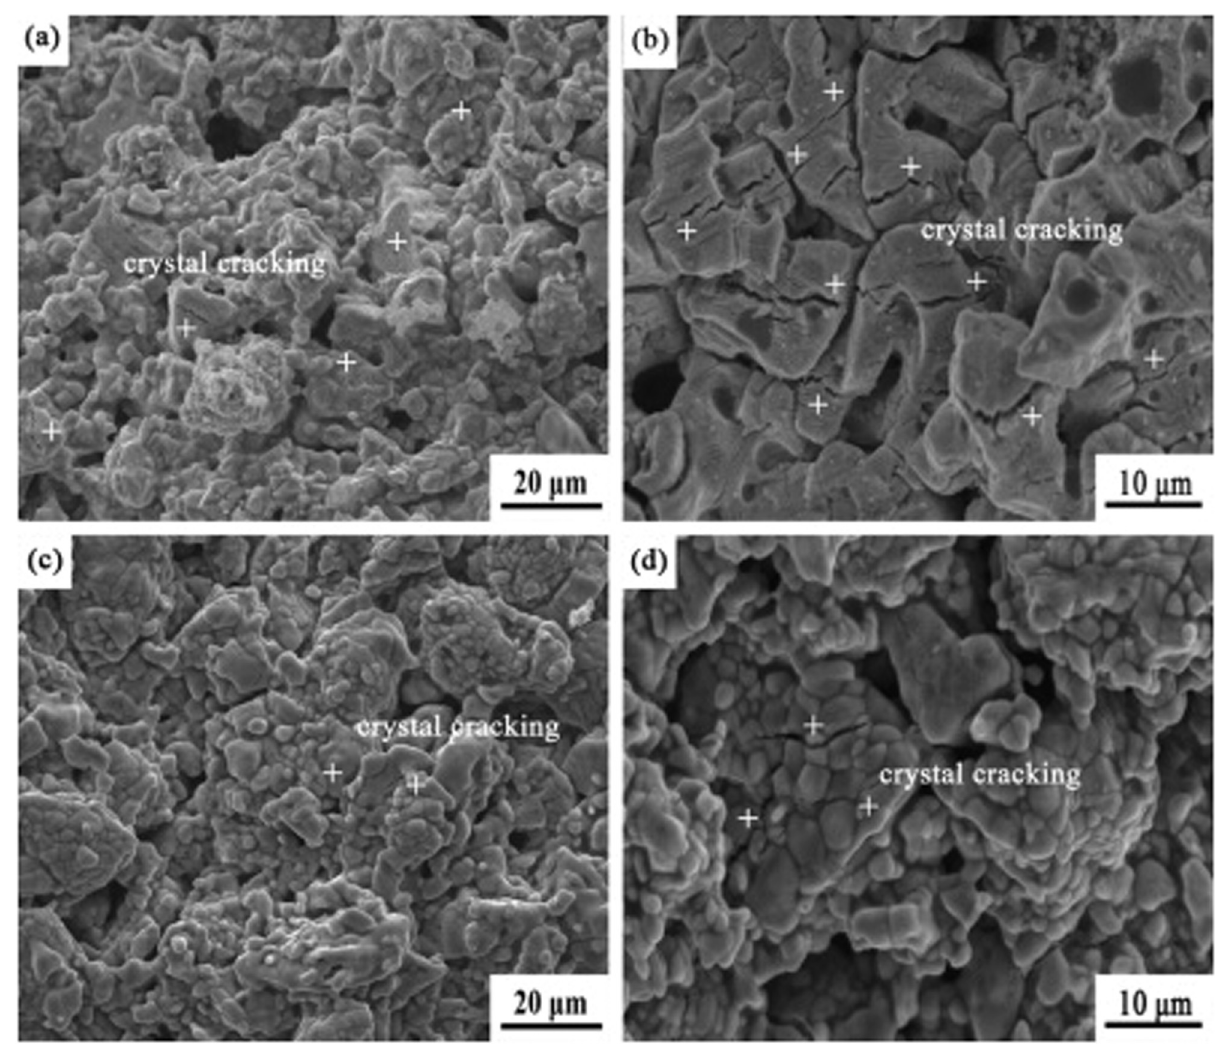
Figure 6: SEM images of reduced briquettes at the first stage. ( a and b ) Mineral structure and morphology of 0 wt% ( K 2 O + Na 2 O ) ; ( c and d ) mineral structure and morphology of 0.6 wt% ( K